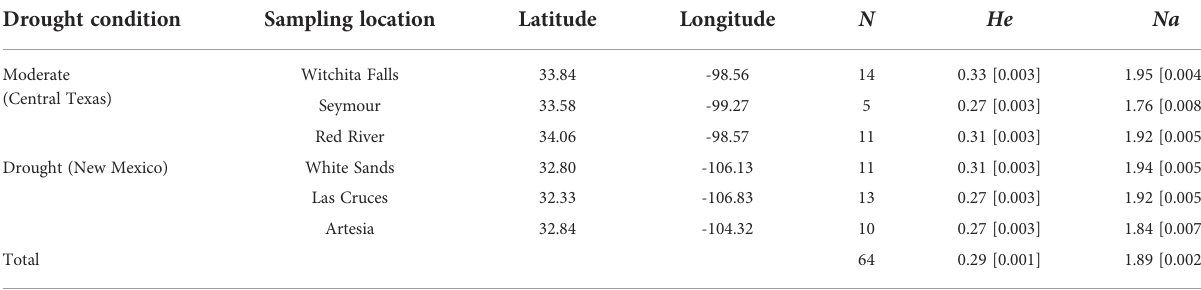
TABLE 1 Summary statistics of genetic diversity and regional information of sampling sites with geographical position. Drought